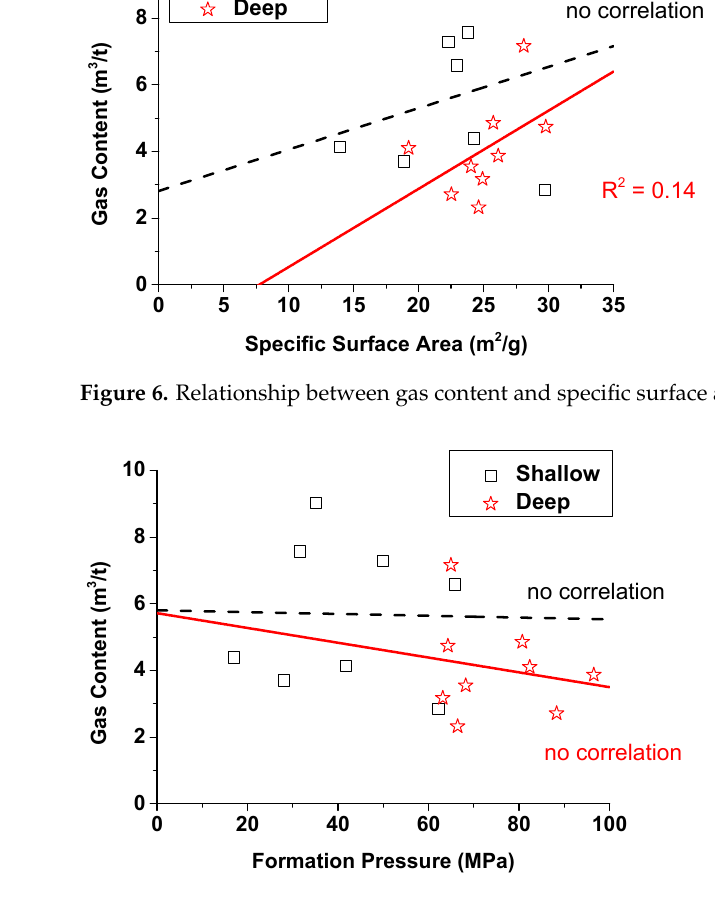
Figure 7. Relationship between gas content and formation pressure.